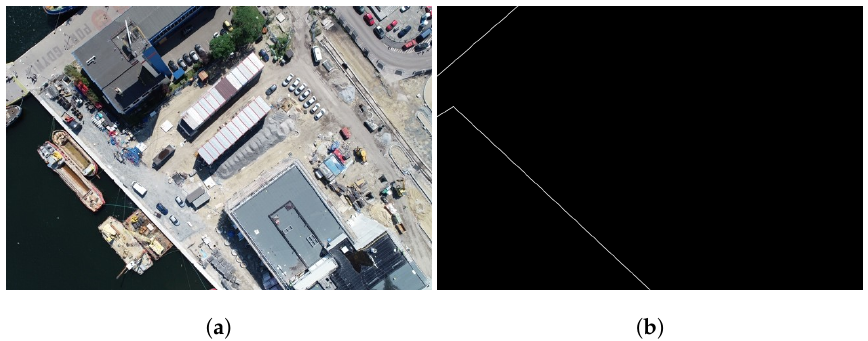
Figure 5. Coastline image: ( a ) on the photo with geometric distortions removed, ( b ) obtained as a result of perspective projection of the edge of the land area from the ENC